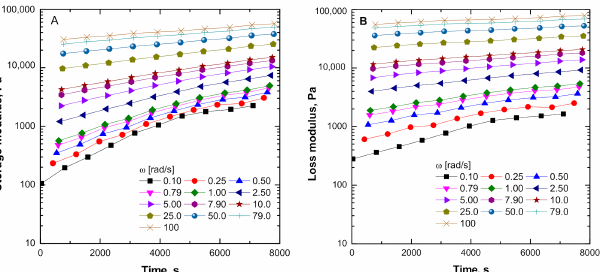
Figure 6. Time-resolved mechanical spectroscopy (TRMS) sweeps for ENR+SiO 2 at 180 ◦ C: ( A ) storage modulus and ( B ) loss modulus.